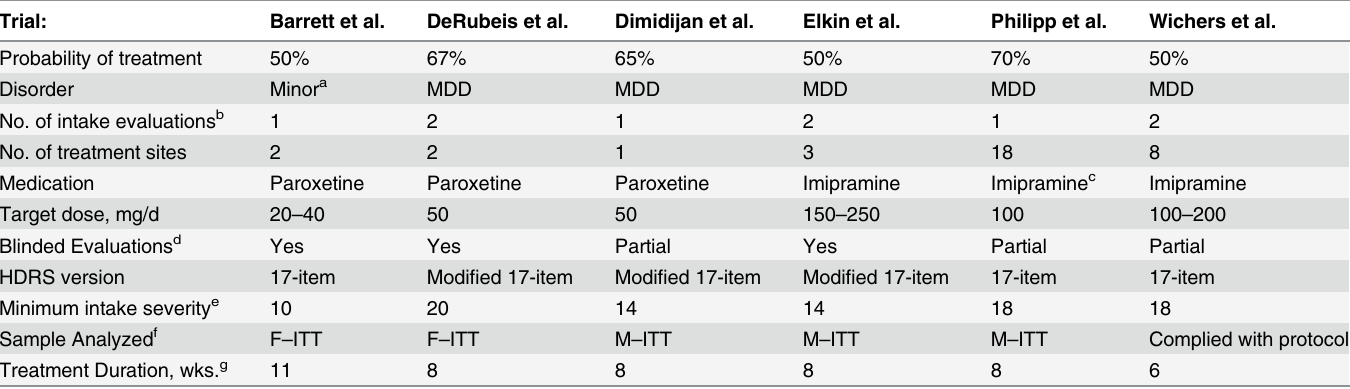
Table 1. Details of 6 Studies of Medication and Placebo for Depressed Outparticipants (Table 1 of Fournier et al.,